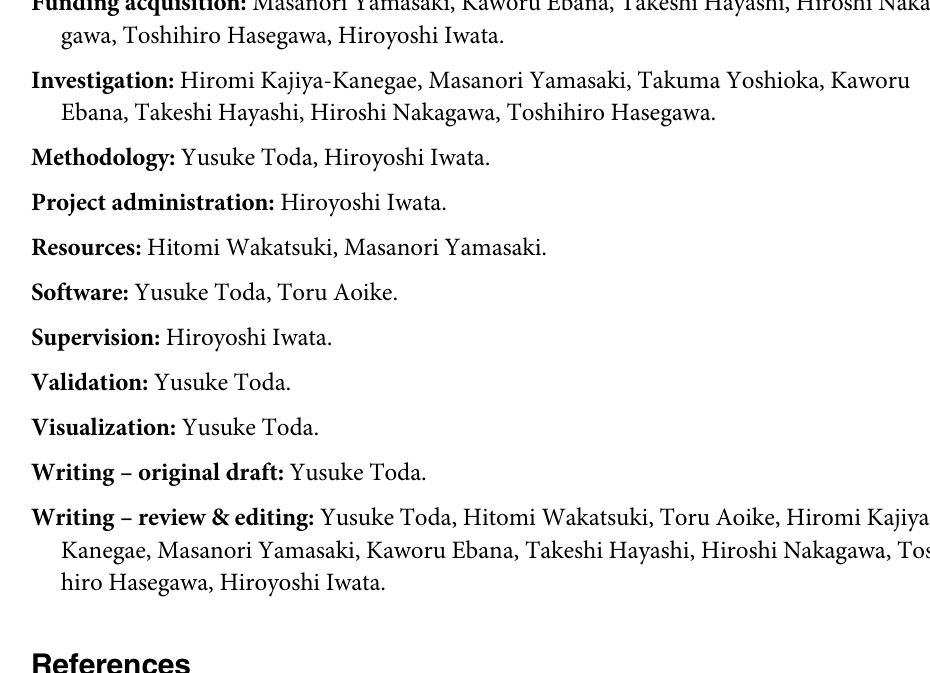
S1 Table. List of information of genetic markers. S2 Table. List of names of 112 Japanese cultivars used to estimate growth parameters of heading date. S3 Table. Results of ANOVA test of observed traits to detect the effect of G × E. S4 Table. Calculation of wide-sense heritability of observed traits using